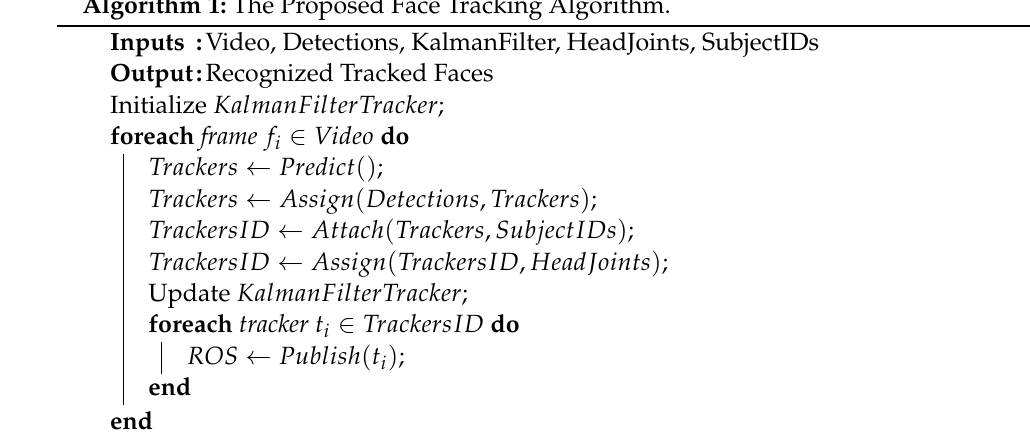
Algorithm 1: The Proposed Face Tracking